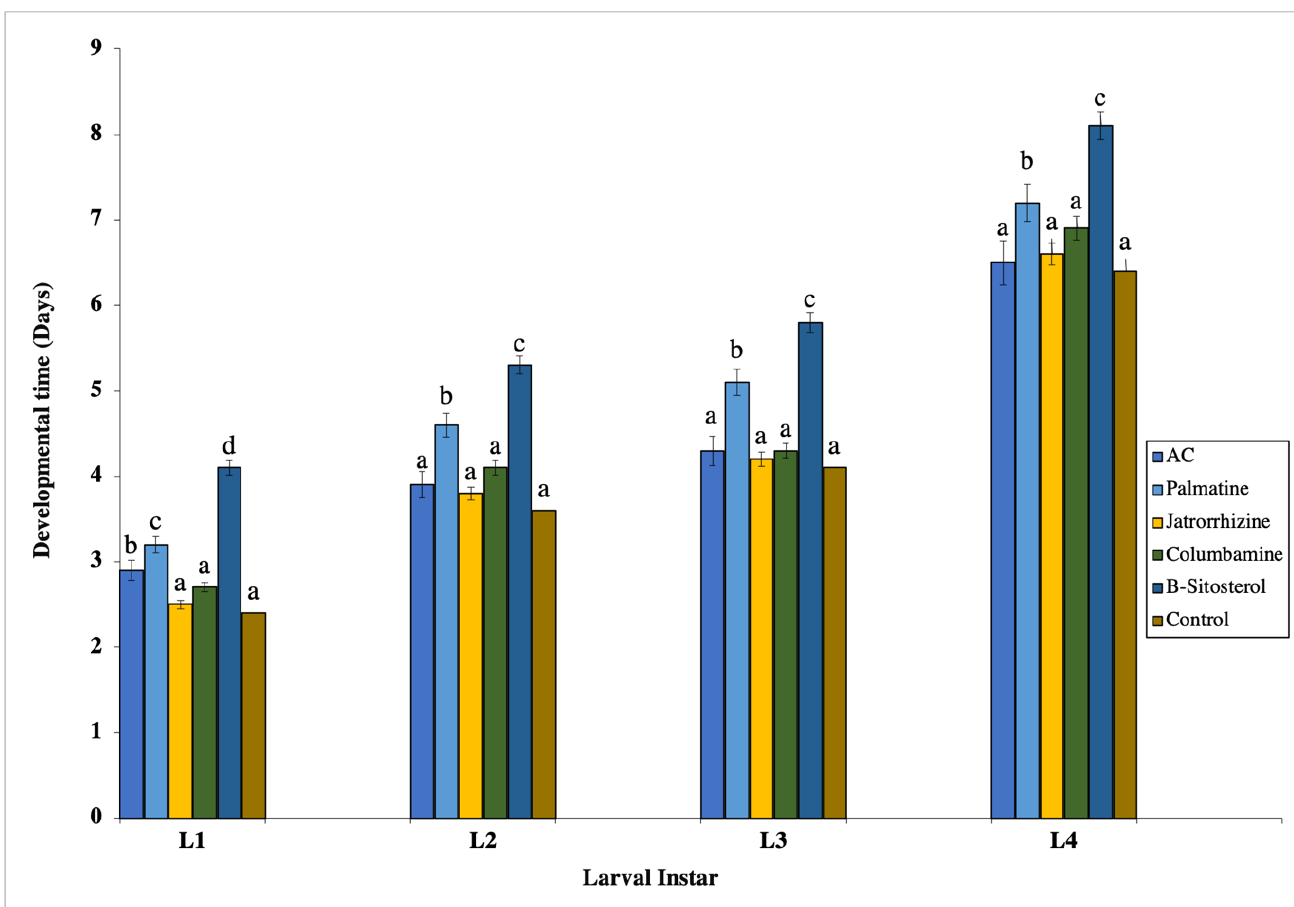
Figure 2. Effect of tested LC 50 concentrations of palmatine, jatrorrhizine, columbamine, β - sitosterol, and Annickia chlorantha extract (AC) on the mean developmental durations of Culex pipiens larvae. Bars with different letters are significantly ( p < 0.05) different. Data presented as mean ± SE. Three replicates were used in each treatment. Sample size ( n ) = 75 for the control and L1 groups; n = 45 for the L2 group; n = 41 for the L3 group; and n = 36 for the L4 group. Sample sizes were almost the same for the different tested compounds.